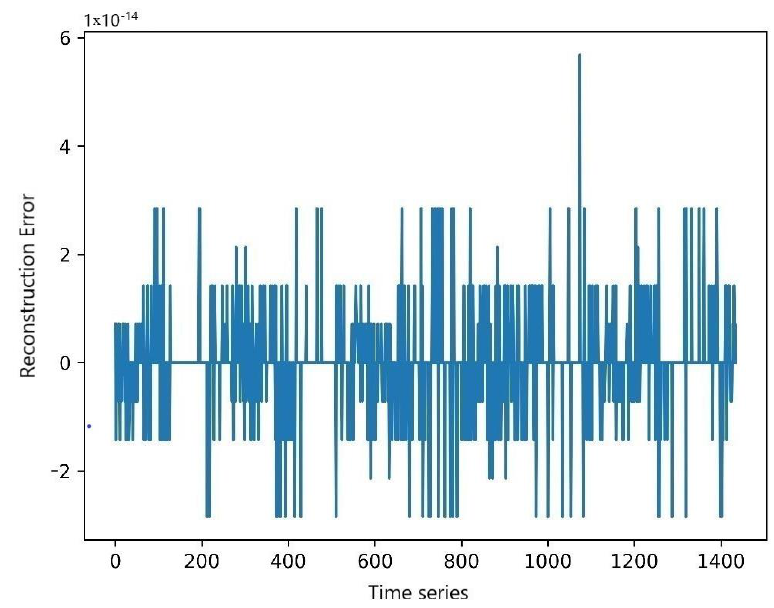
Figure 7. CEEMDAN decomposition traffic flow reconstruction error plot.